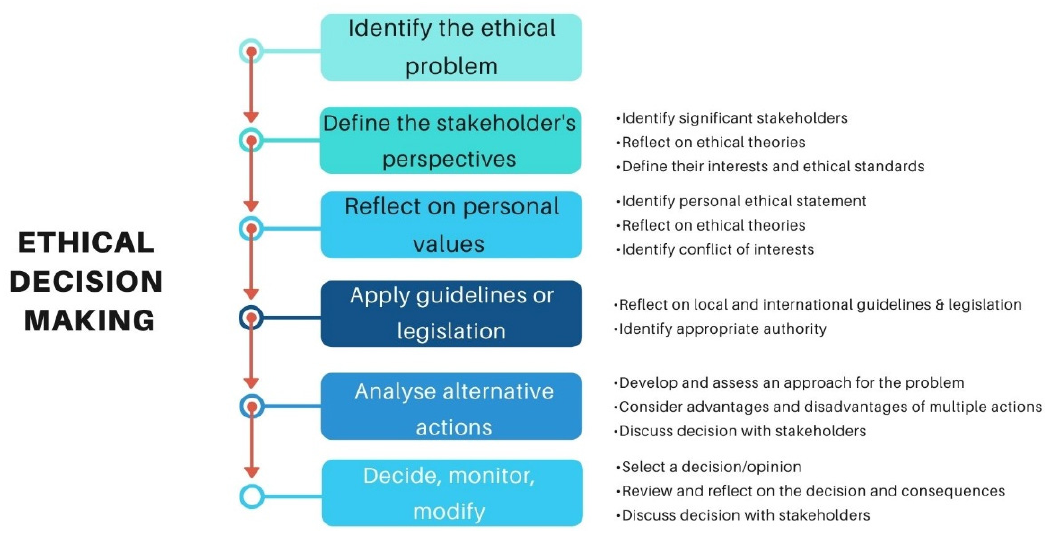
Figure 1. Common steps in veterinary ethical decision-making. Scenario 1: Use of gestation stalls on pig farms